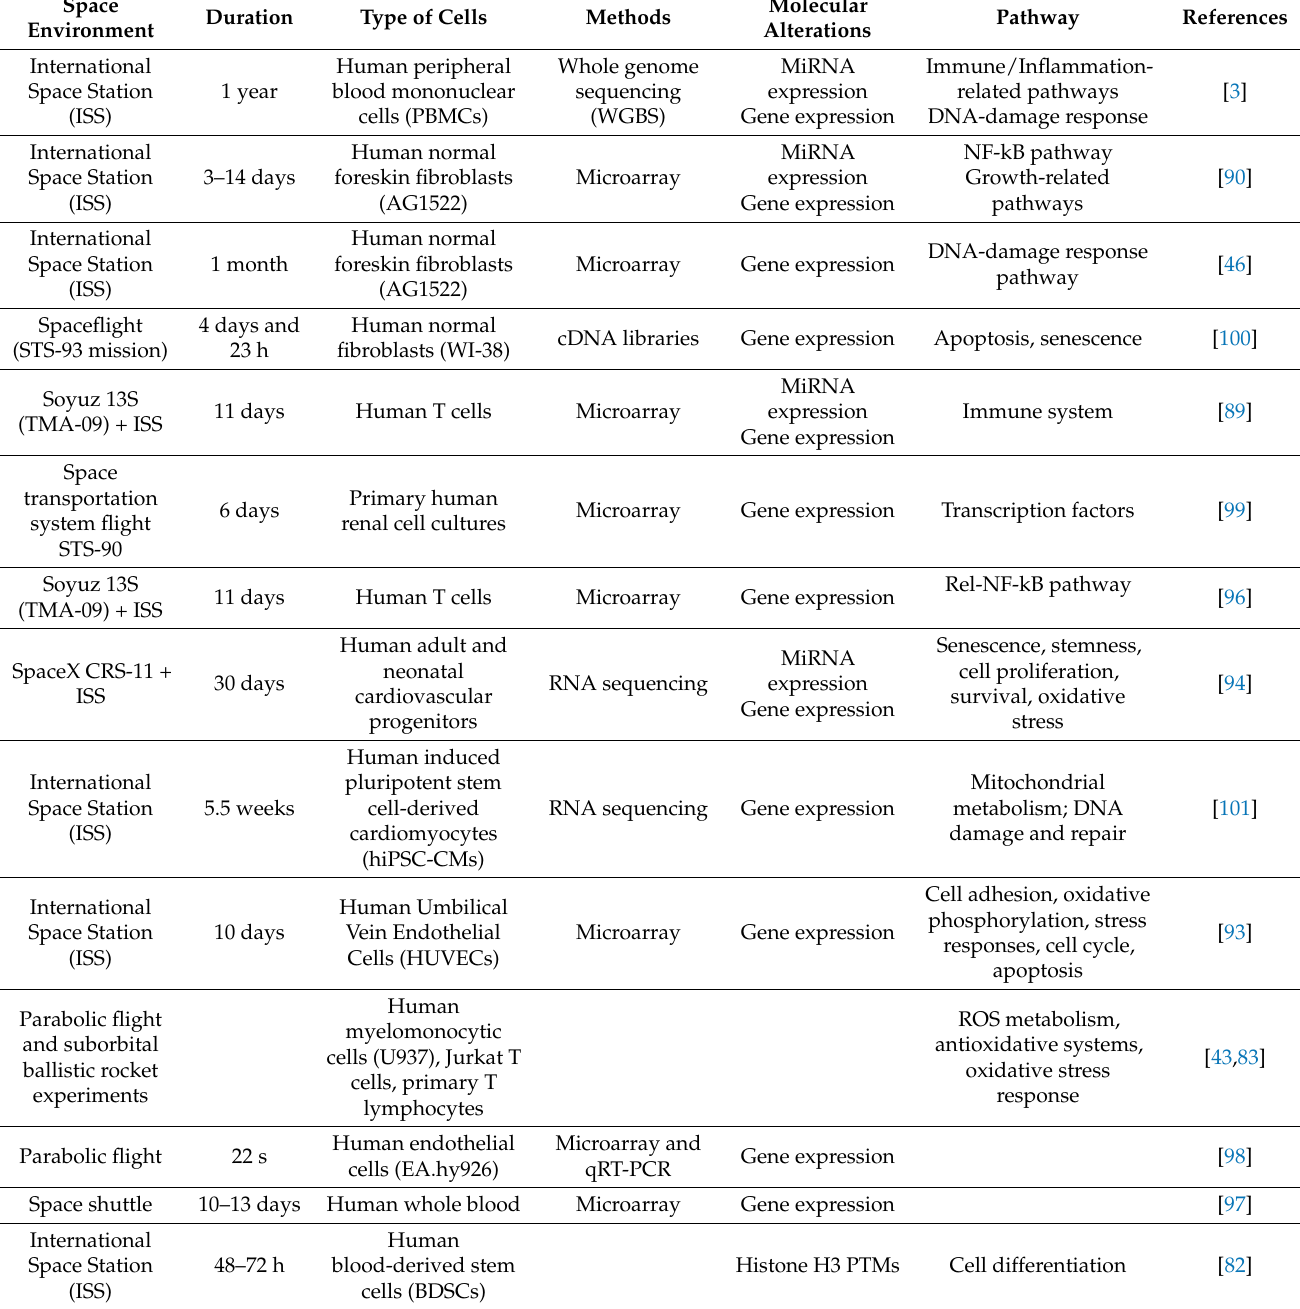
Table 1. Genomic alterations in human space-flown